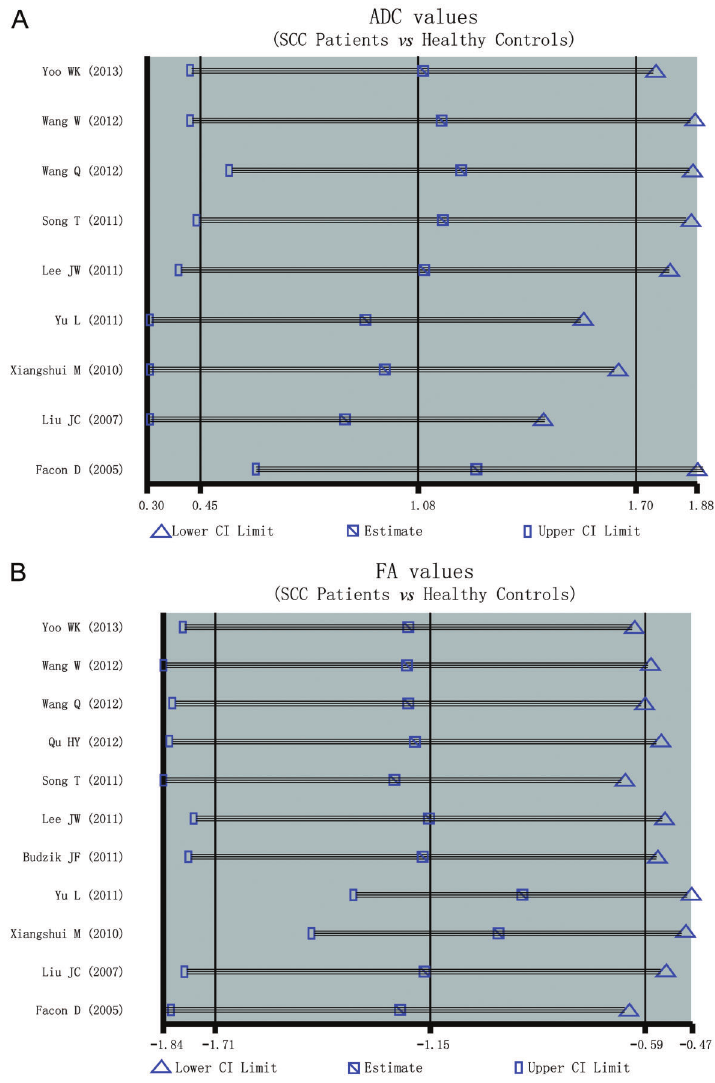
Figure 4. Sensitivity analysis of the summary odds ratio coef fi cients on the difference in the frequency of the apparent diffusion coef fi cient (ADC) and fractional anisotropy (FA) values between patients with spinal cord compression (SCC) and healthy subjects ( A , ADC; B , FA value). See Figure 1 for reference